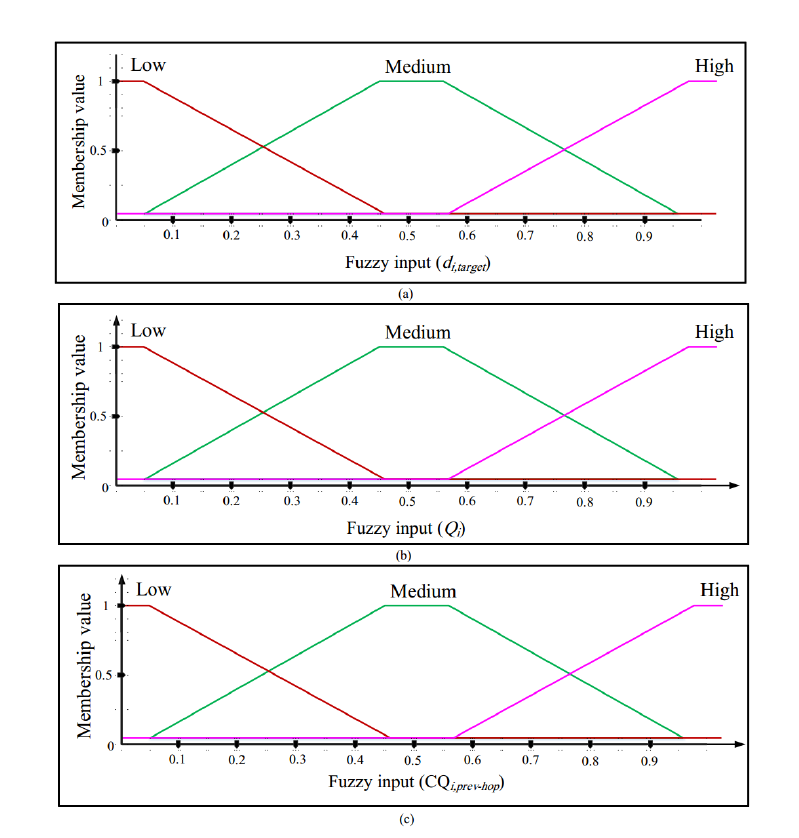
Figure 8. Fuzzy inputs.